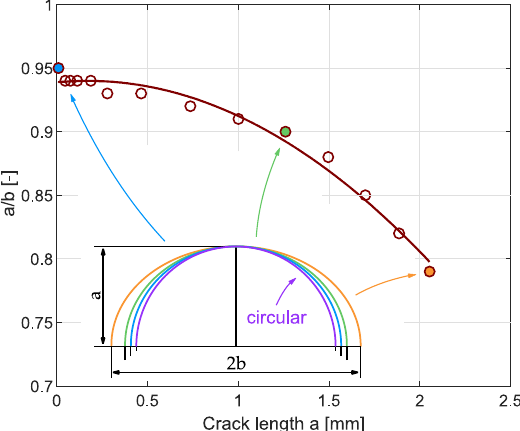
Figure 11. Ratio of the semi-axes of semi-elliptical crack a/b vs. crack length a.